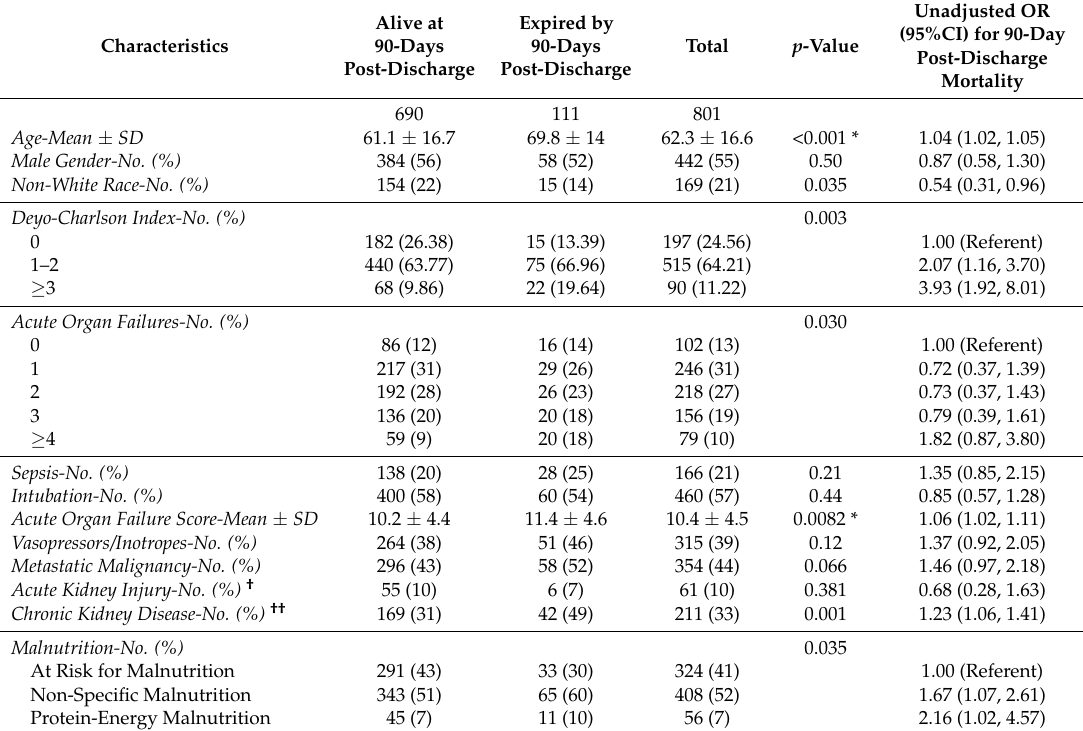
Table 1. Clinical and demographic characteristics of the study cohort ( n =